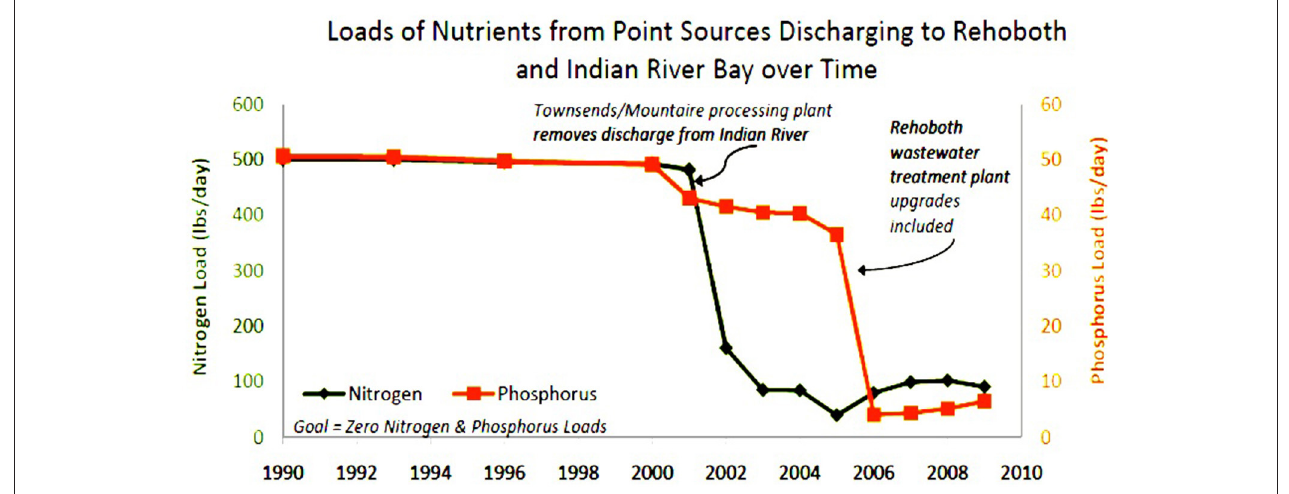
FIGURE 1 | Reduction of nutrient loads from point sources discharges in Rehoboth and Indian River Bay from 1990 to 2009